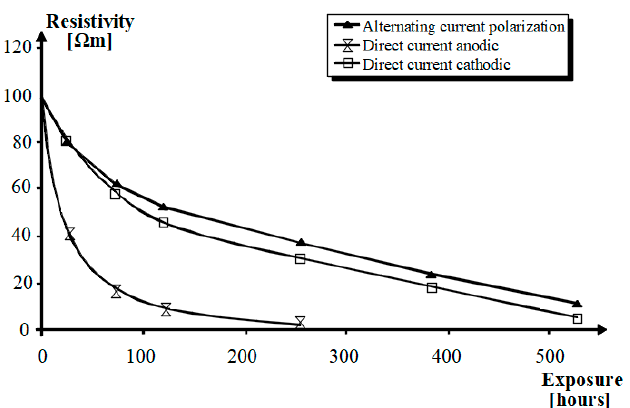
Figure 2. The change in bulk electrical resistivity of reinforced concrete samples in the case of different polarization treatments. In all cases current values equal to 3 mA/cm 2 .